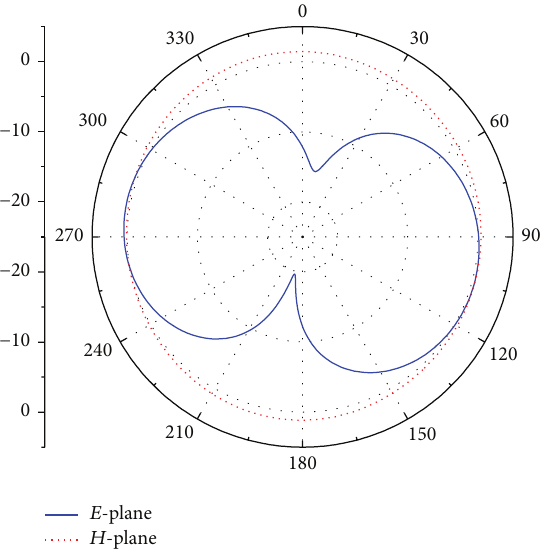
Figure 8: Simulated 𝑆 -parameters in three cases: without DGS, with dual slots, and with full